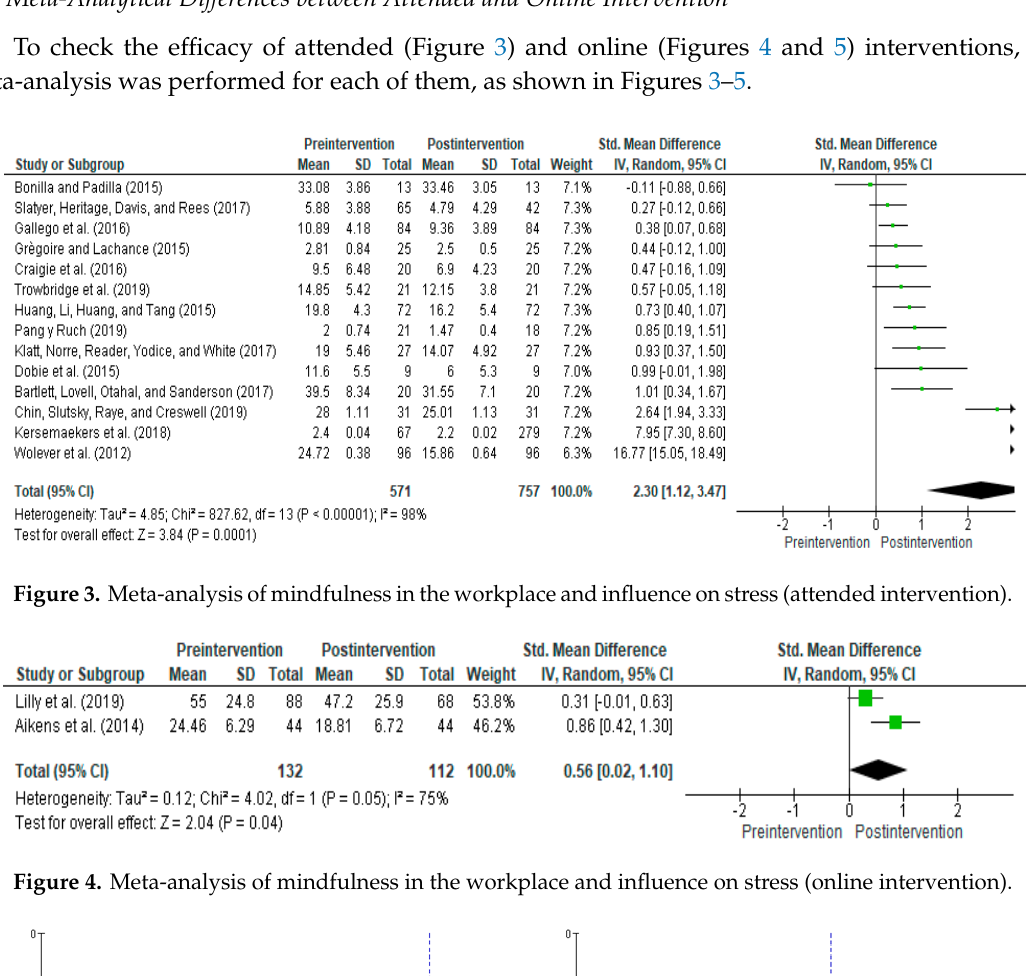
Figure 2. Risk of bias for all variables. (a) Mindfulness. (b) Depression and anxiety. (c) Negative and positive affects. (d) Emotional exhaustion and burnout. (e) Fatigue. (f) Stress. (g) Engagement. (h) Resilience. (i) Wellbeing. (j) Quality of sleep.